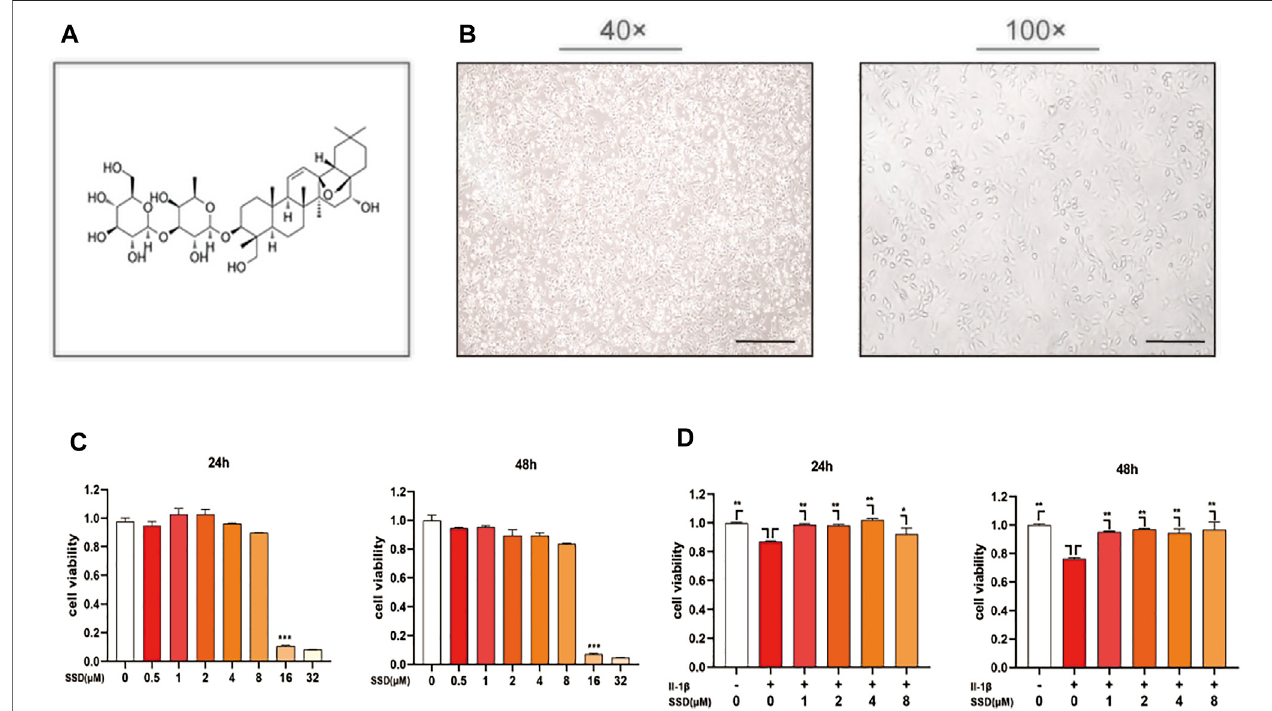
FIGURE 1 | SSD improved the cell viability of the cells stimulated by IL-1 β and prevented cell death. (A) The chemical structure of SSD. (B) The morphology of ATDC 5 chondrocytes under the microscope (40×; 100×; Scale, 200 μ m). (C) Effects of various concentrations of SSD on the cell viability. (D) The protective effects of SSD on the cells stimulated by IL-1 β